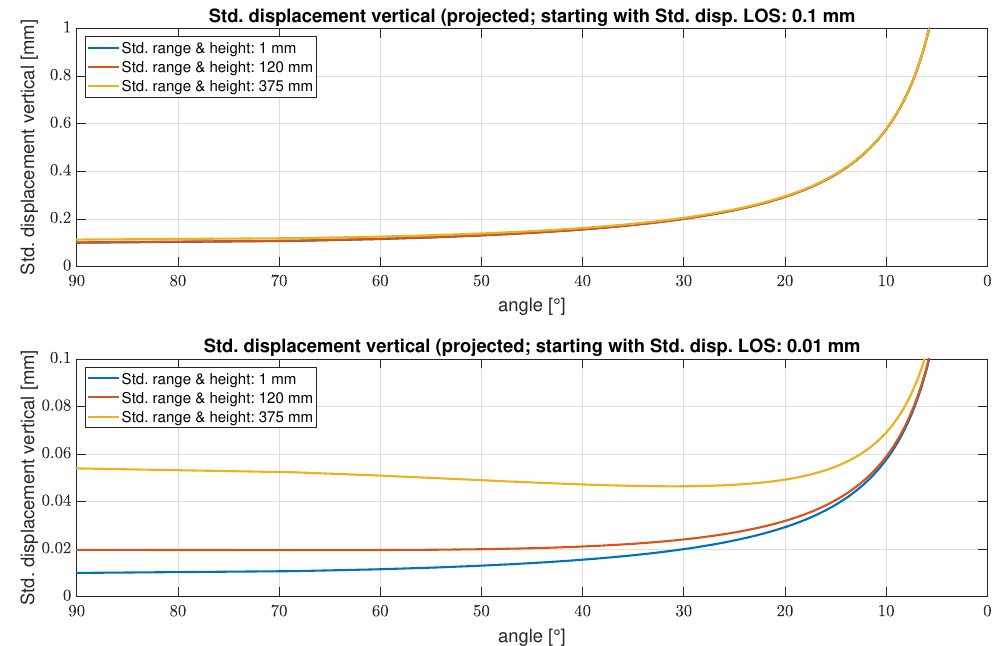
Figure 4. Uncertainty of the projected displacements (vertical) for different standard deviations of the LOS displacement (upper vs. lower graphic), projection angles and precision of range and height for the resolution